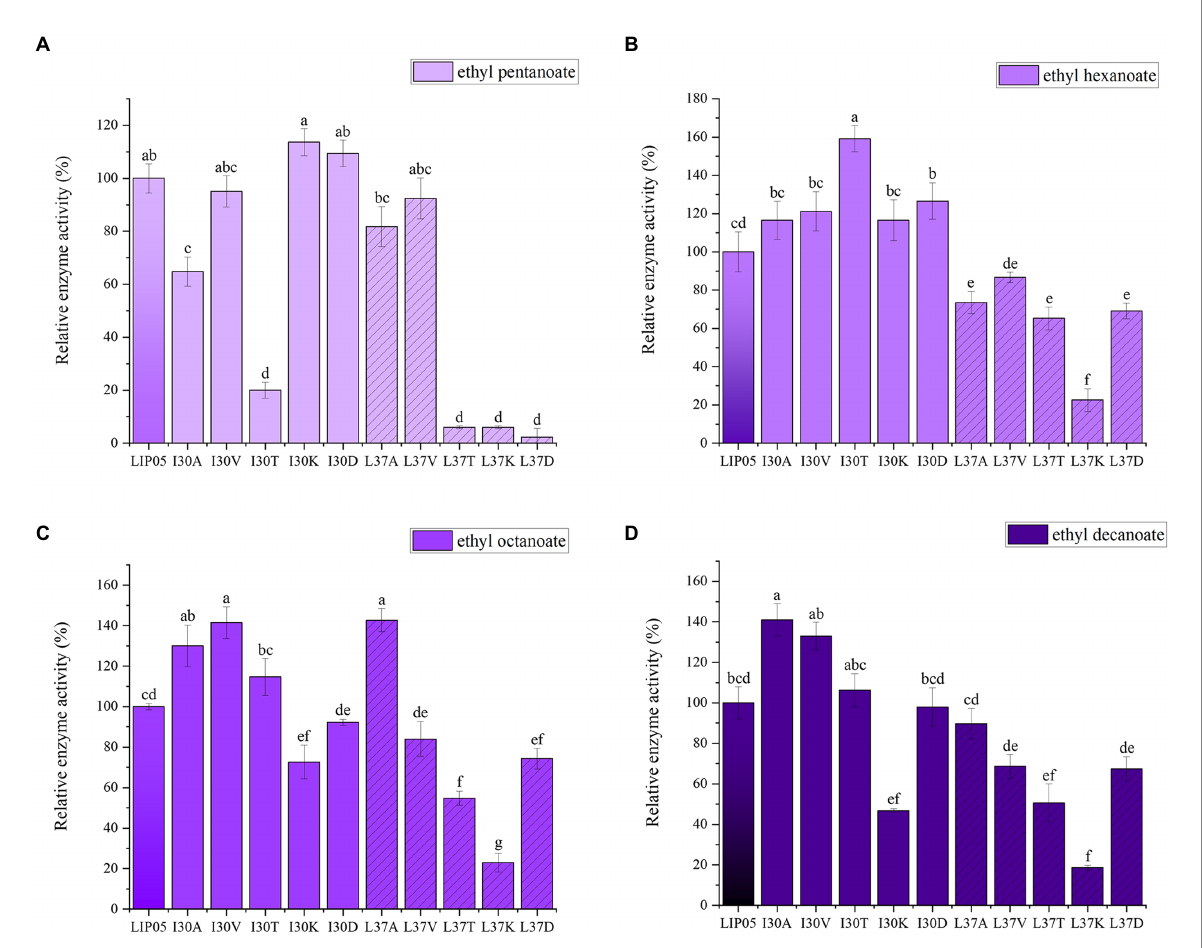
FIGURE 3 The ester synthesis ability of the mutants at Ile30 and Leu37. (A) Synthesis of ethyl pentanoate, (B) Synthesis of ethyl hexanoate, (C) Synthesis of ethyl octanoate, (D) Synthesis of ethyl decanoate. Bars with different letters (a-d) are significantly different ( p <0.05).